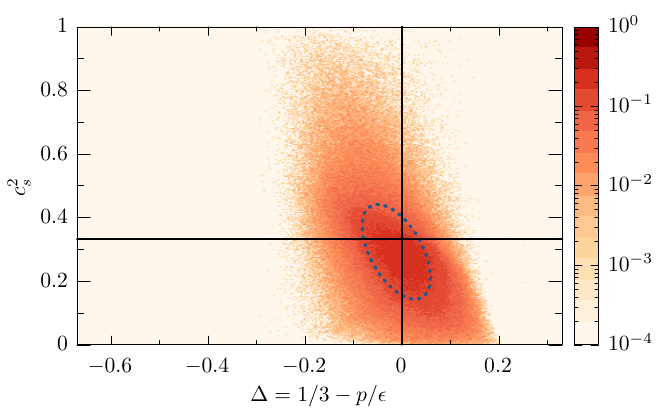
Figure 3. PDF of the the speed of sound vs trace anomaly at the center of maximally stable NSs. The dotted, blue ellipse marks the 1 σ credibility around the mean. The black, solid lines mark the conformal